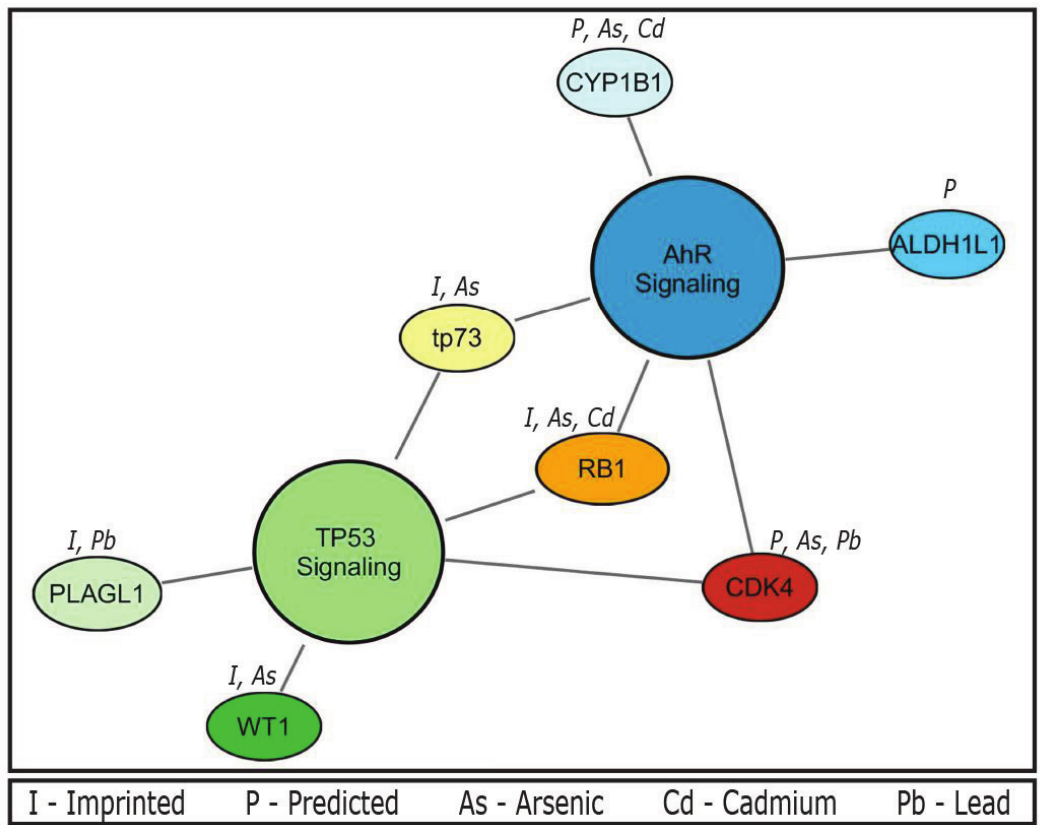
Figure 1. Top canonical pathways and their relationships to toxic metals. The aryl-hydrocarbon receptor (AhR) ( p = 0.001) and TP53 ( p = 0.007) networks display known